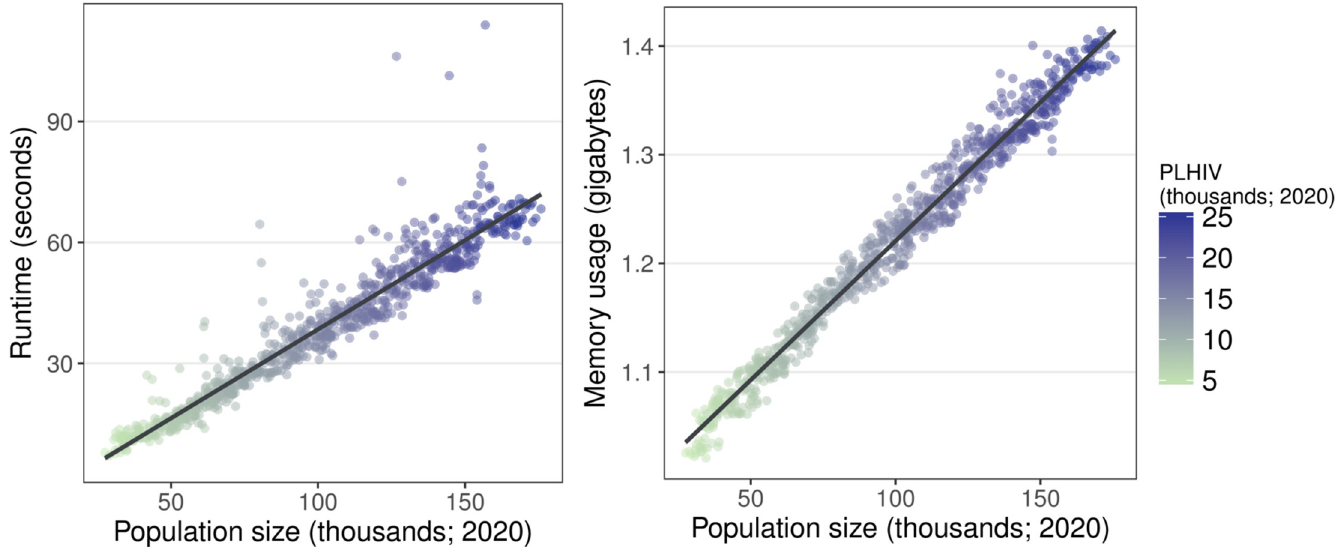
Fig 3. Runtime (left) and memory usage (right) of PopART-IBM for a single randomly chosen calibrated parameter set run for 120 years. Population size and PLHIV were measured in one patch at the beginning of 2020. The model is writing a typical set of files to disk in this experiment, including a time series of HIV prevalence, incidence, ART usage, etc. Shorter runtimes can be enabled during calibration by only writing essential indicators used within the calibration process.